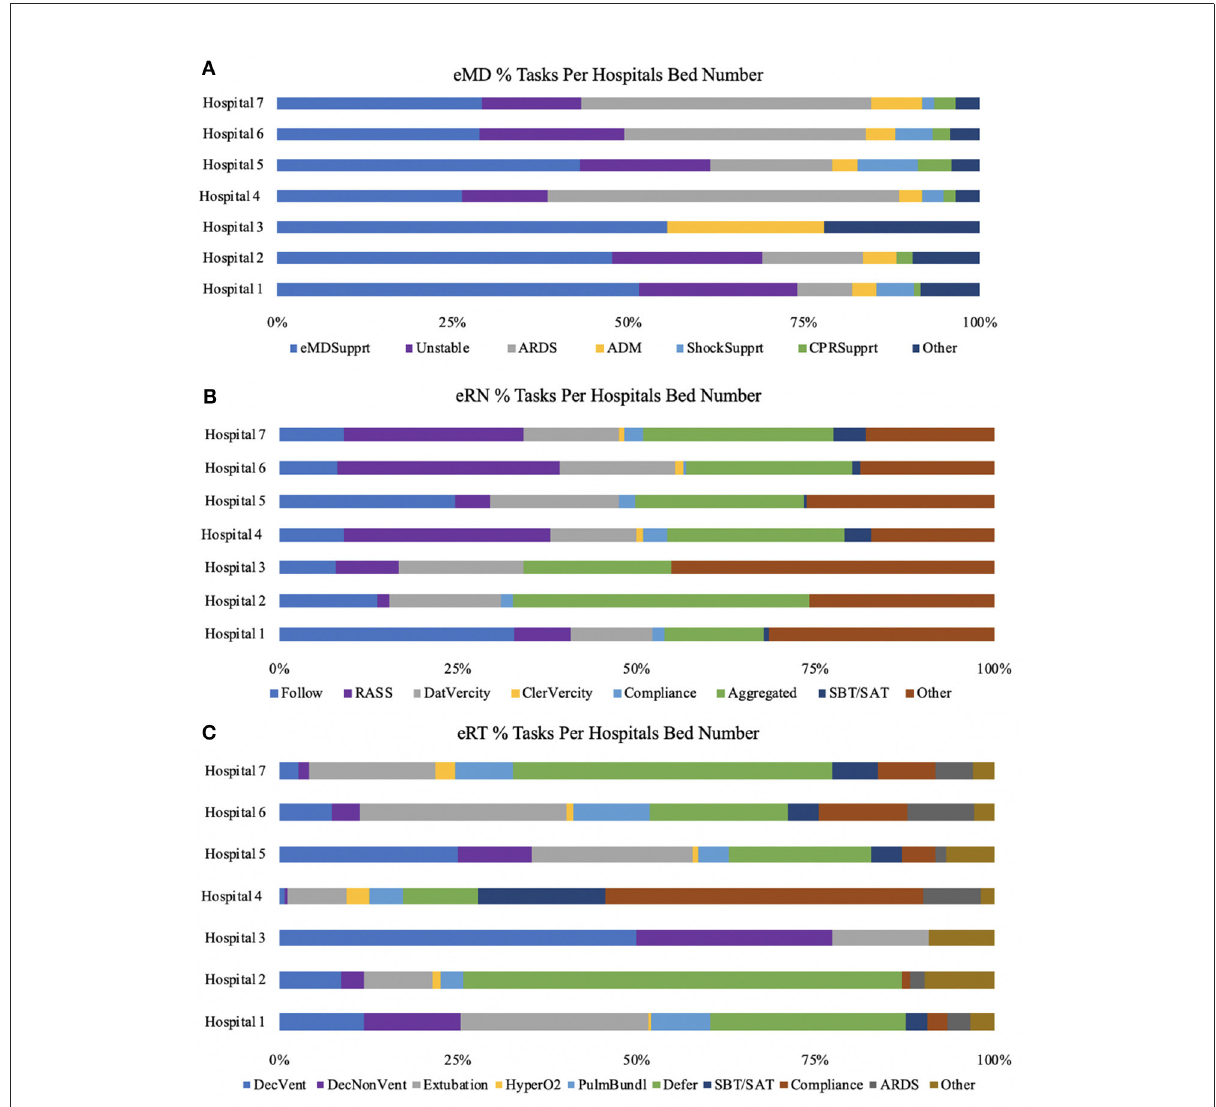
FIGURE4 Percentages of tasks performed varied for each specialty based on the different hospitals. eMD support made up a large percentage of all hospital systems (A) . eRN tasks consisting of RASS was most significant across the larger hospital systems (hospital 4,6,7) (B) . eRTs had more task variability across the different hospital systems, but critical tasks were deference, extubation, and declining vent (C)